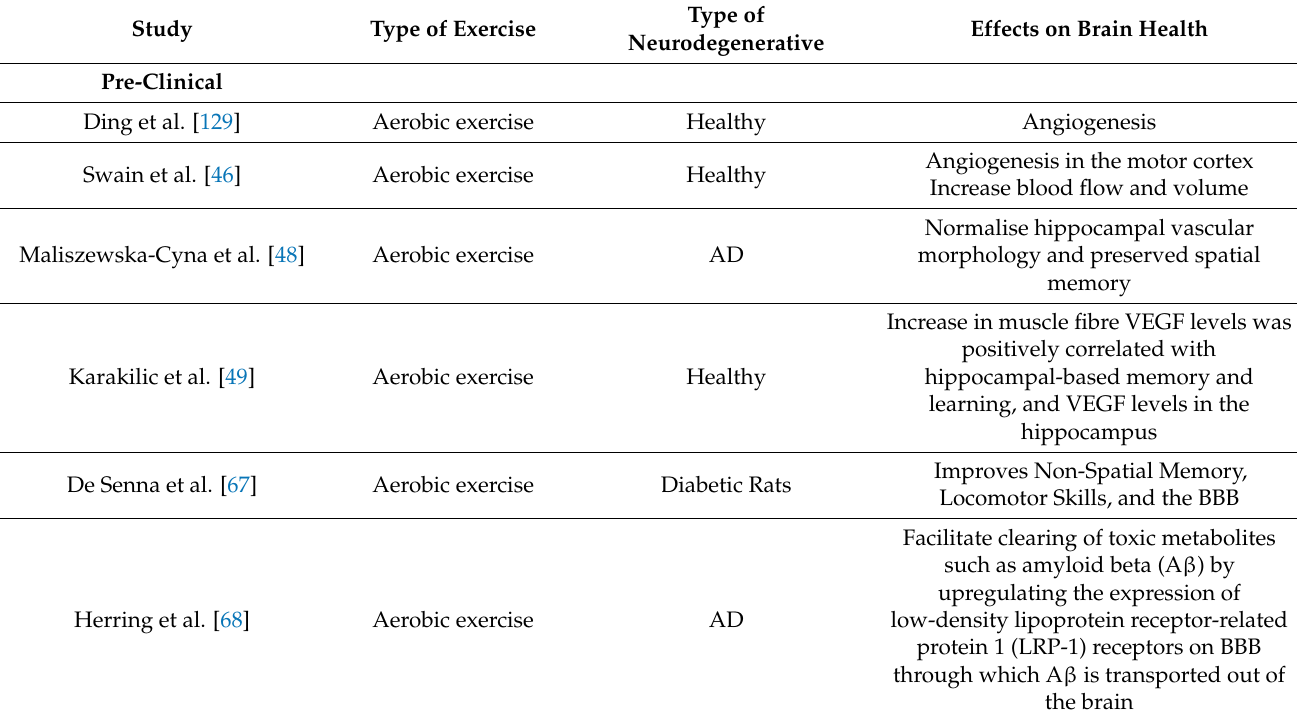
Table 1. Effects of exercise on brain health in pre-clinical